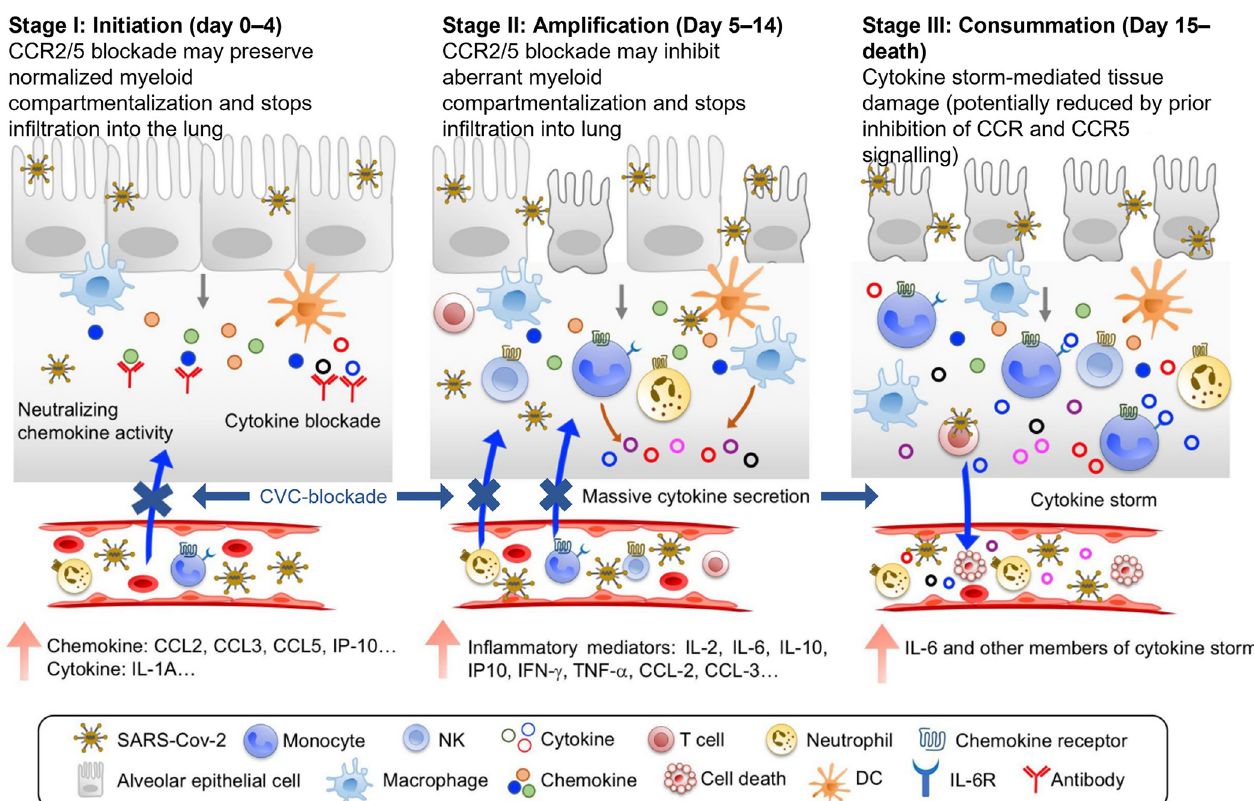
Fig 2. Three stages of immunological pathway leading to mortality in COVID-19: Stage I (Initiation), with early induction of predominant chemokines upon SARS-CoV-2 infection and viral sepsis. Treatment at this stage with CVC (highlighted in blue text and arrows) is postulated to maintain normalized myeloid compartmentalization at early stage of infection, or block aberrant myeloid infiltration upon CCL2, 3, and 5 signaling following SARS-CoV-2 infection and consequent cytokine amplification (Stage II), and subsequent tissue damage and eventual death (Stage III—consummation). Lu L, et al. Preventing Mortality in COVID-19 Patients: Which Cytokine to Target in a Raging Storm? Front Cell Dev Biol . 2020;8:677. https://doi.org/10.3389/fcell.2020. 00677. CCL, chemokine-chemokine ligand; CCR, chemokine-chemokine receptor; COVID-19, Coronavirus Disease 2019; CVC, cenicriviroc; IL, interleukin; IP, interferon gamma-induced protein; SARS-CoV-2, Severe Acute Respiratory Syndrome Coronavirus 2; TNF, tumor necrosis factor.